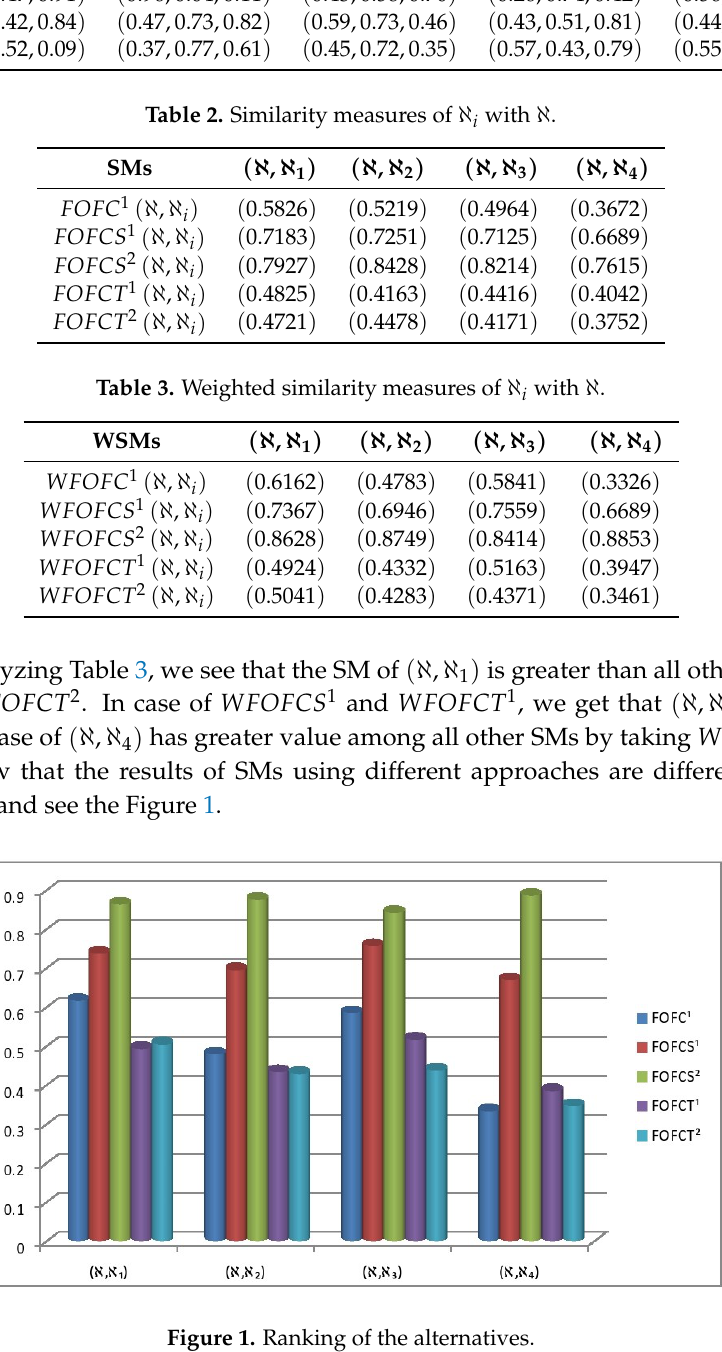
Figure 1. Ranking of the